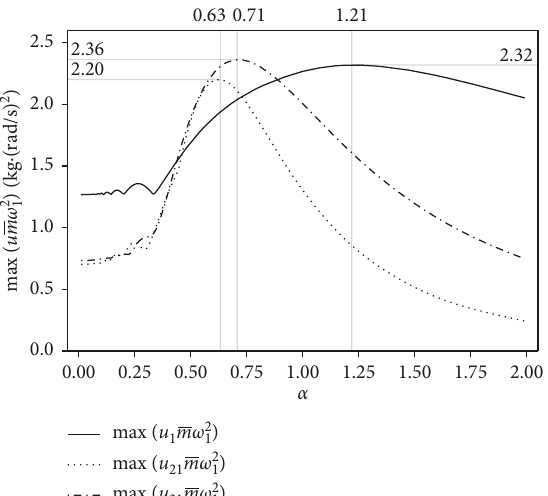
Figure 6: The maximum displacement curves of the beam under three kinds of moving load conditions with different speed parameter α ( n � 1; η � 1 . 3; β m � 0; α is from 0 to 2).